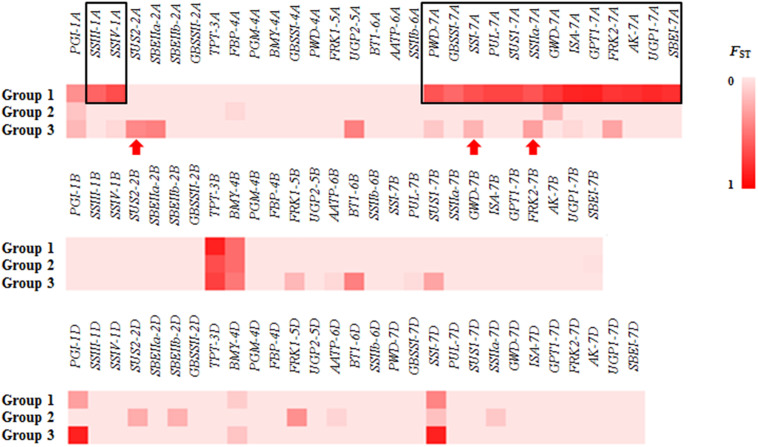
The FST for all of the genes in different groups. Large differences in FST between Group 1 and Group 2/3 were detected at 15 genes (black rectangle). Red arrow: gene associated with thousand kernel weight (TKW) had a different FST in Group 3.